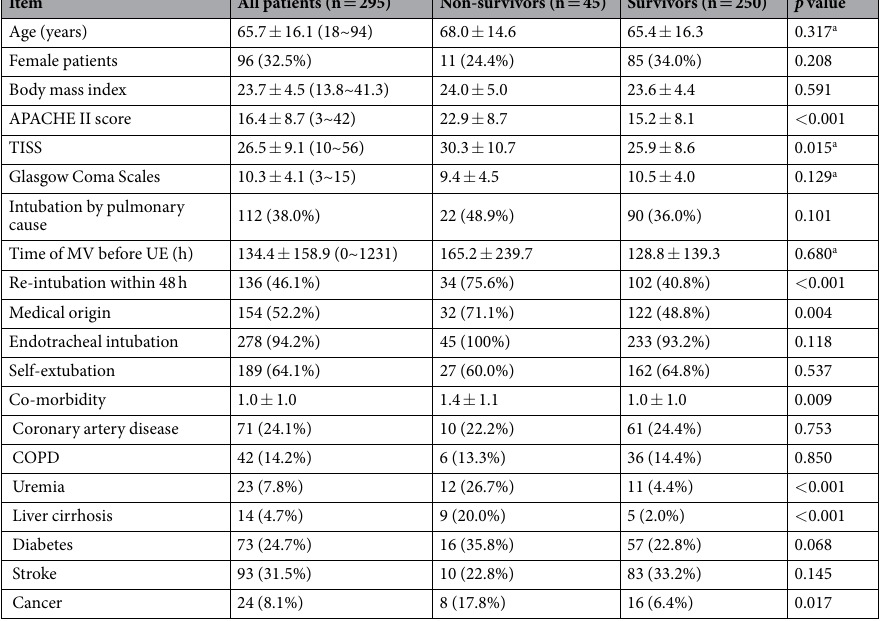
Table 1. Demographic and clinical variables of the different unplanned extubation (UE) groups. Expressed as mean ± SD (range) or n (%); APACHE II = Acute Physiology and Chronic Health Evaluation; TISS = Therapeutic Intervention Score System; COPD = chronic obstructive pulmonary disease. a The Mann- Whiney U test was used owing to not being normally